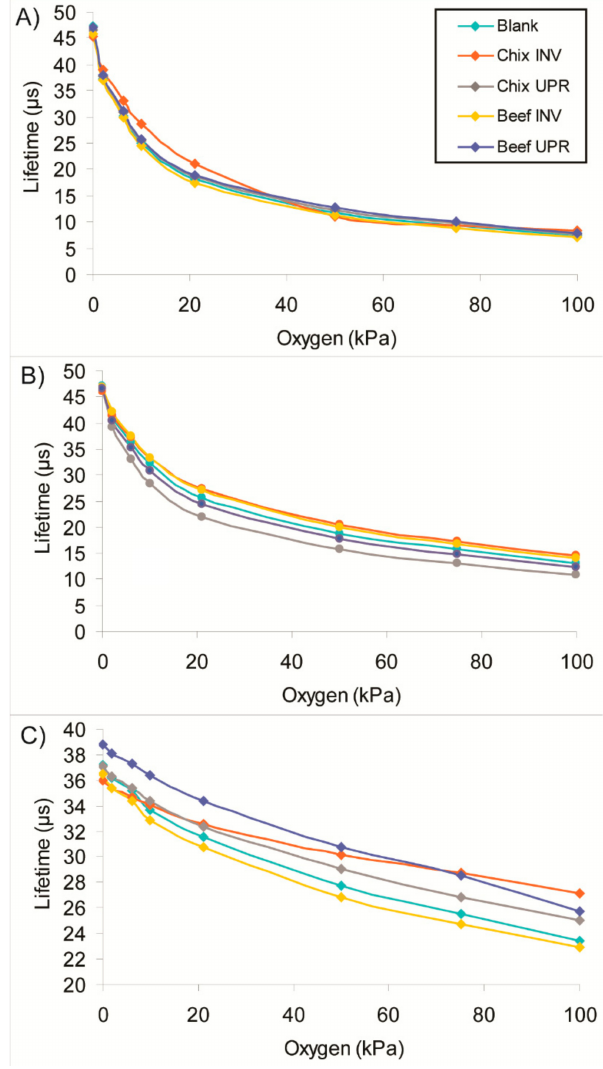
Figure 3. Changes in lifetime calibrations of: Type 2 ( A ); Type 1 ( B ); and Type 5 ( C ) sensors upon seven-day exposure to MAP meats. Measured at 20 ◦ C in dry